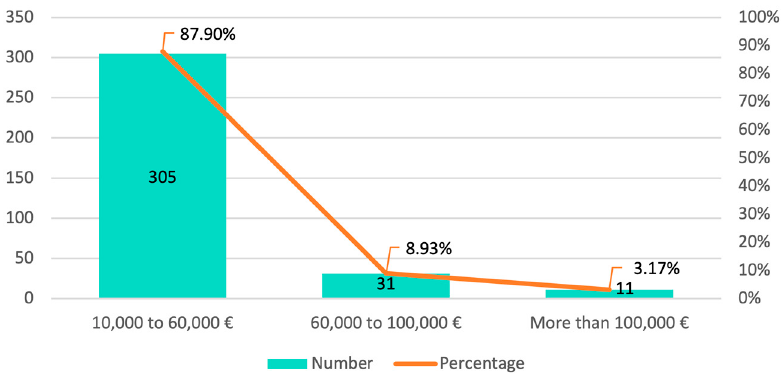
Figure 4. Distribution by frequency and percentages of the decrease in income in dental clinics.